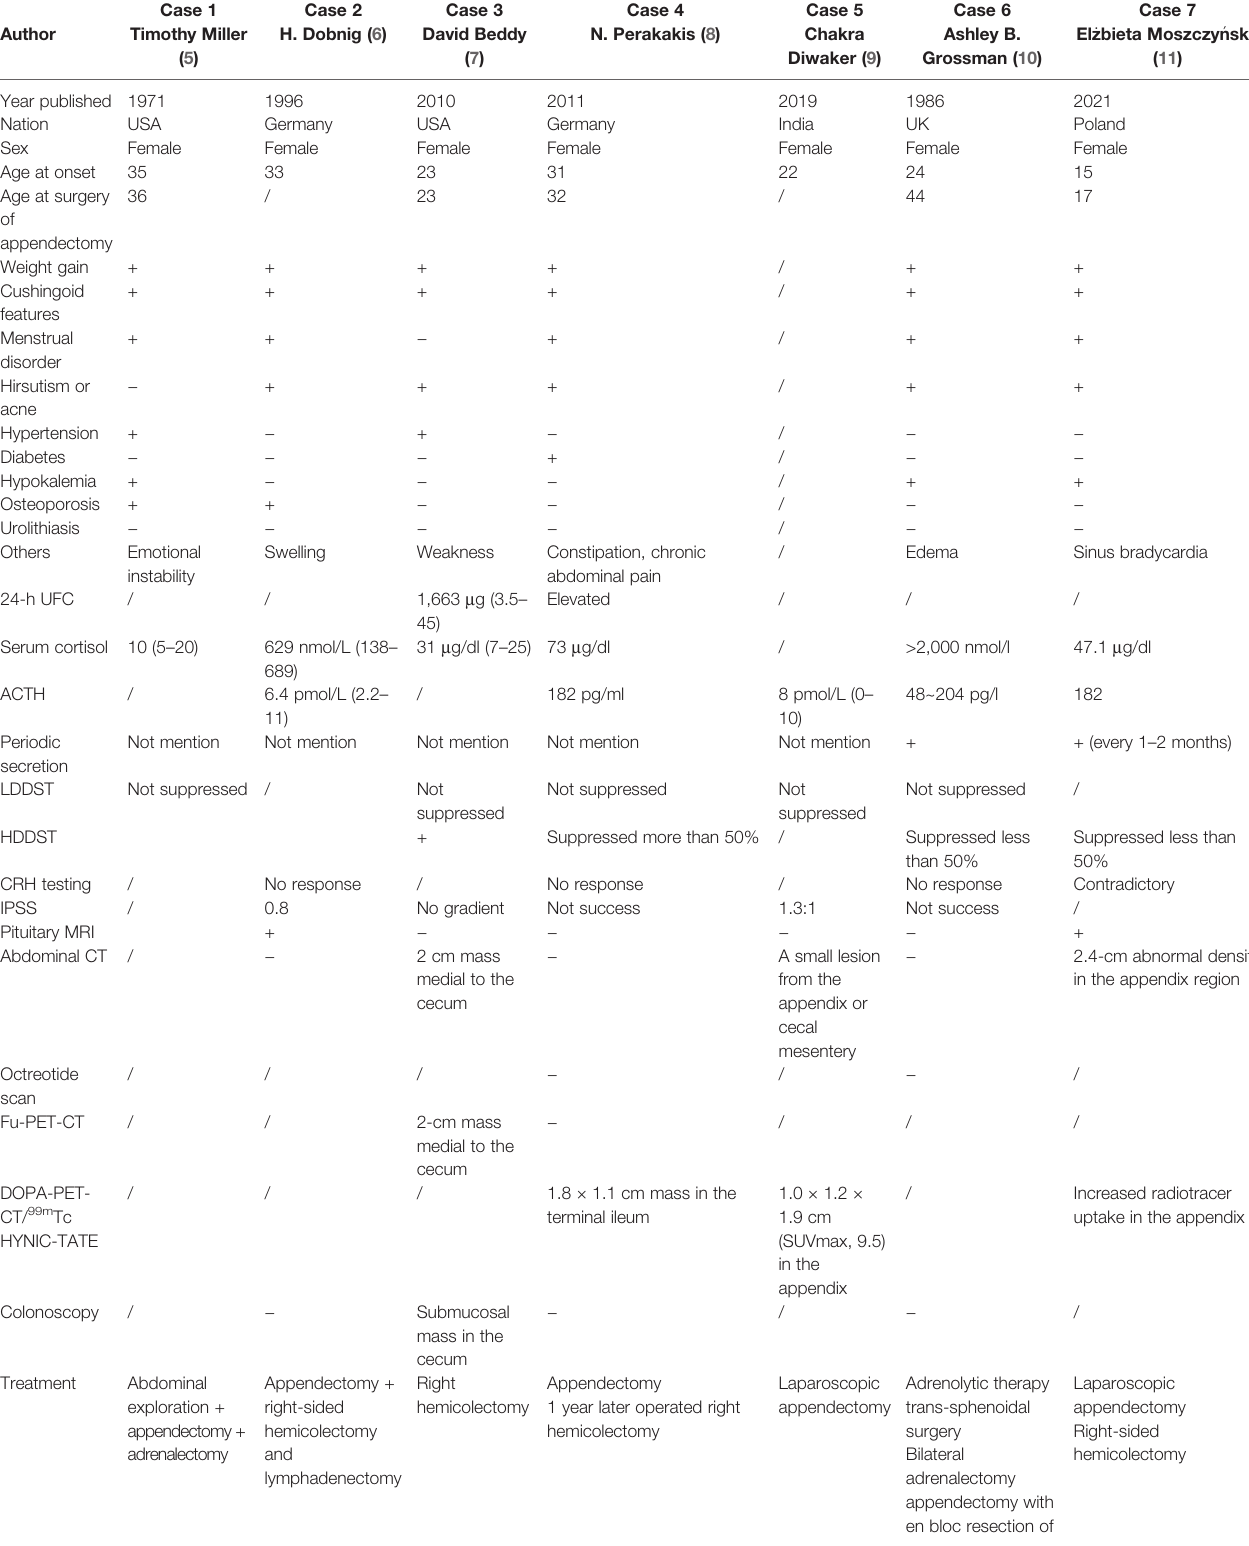
TABLE 3 | Characteristics of cases with IGSF1 de fi ciency from published